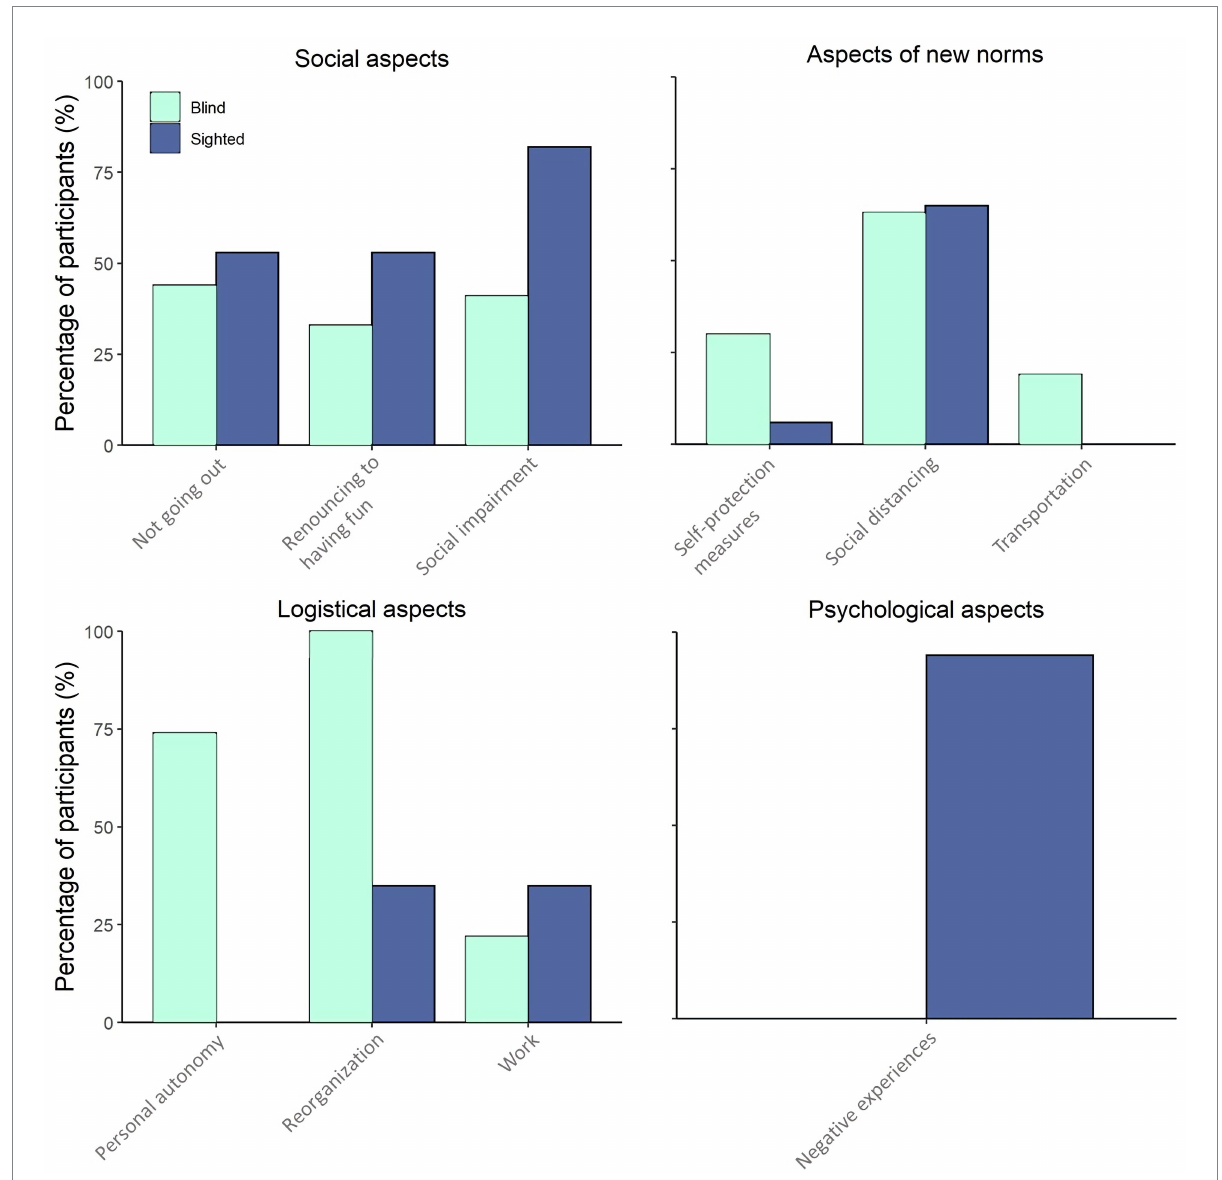
FIGURE 1 Results of the open-ended question: percentage of participants answering the open-ended question and reporting difficulties in the following categories: social aspects, aspects of new norms, logistical aspects, and psychological aspects. Each category is divided into different dimensions related to the main topic of that category. In light blue is the blind group; in dark blue is the sighted control